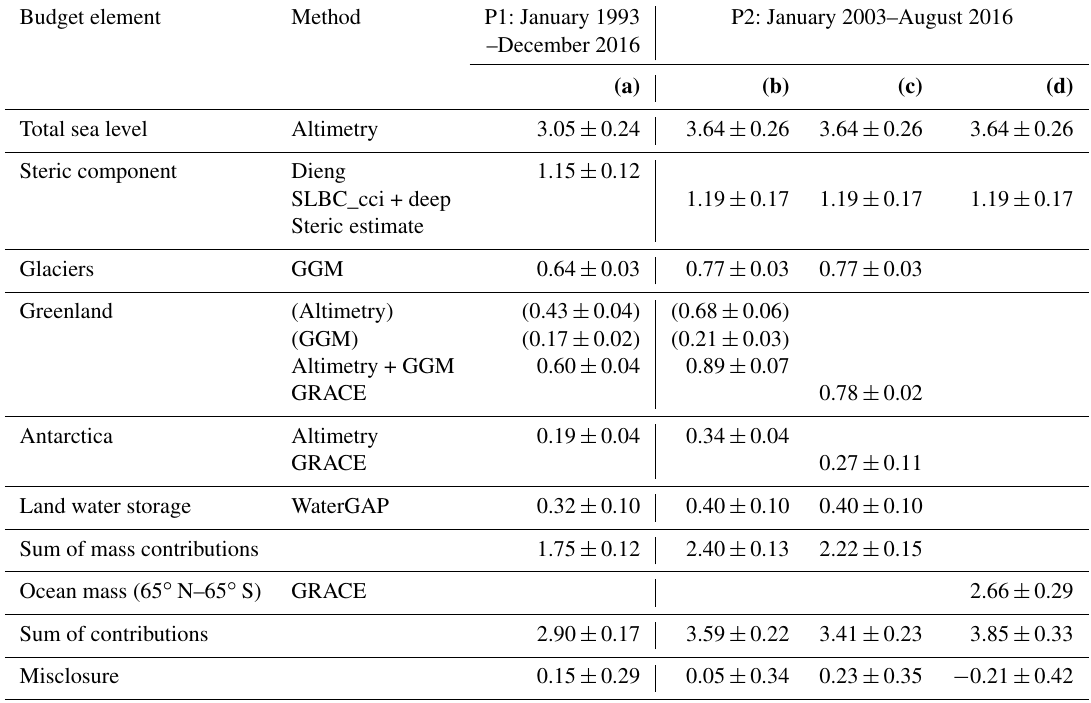
Table 4. Linear trends of the sea-level budget elements (millimetre equivalent of global mean sea level per year) for the intervals P1 (column a ) and P2 (columns b, c, d ) and their standard uncertainties. Different columns adopt alternative estimates of some of the budget elements (as indicated by line labels and footnotes), while adopting the same estimates for other elements. The estimates of total sea level, the steric contribution, and the GRACE-based OMC refer to the ocean between 65 ◦ N and 65 ◦ S, thereby excluding polar and subpolar oceans in the Arctic and the Southern